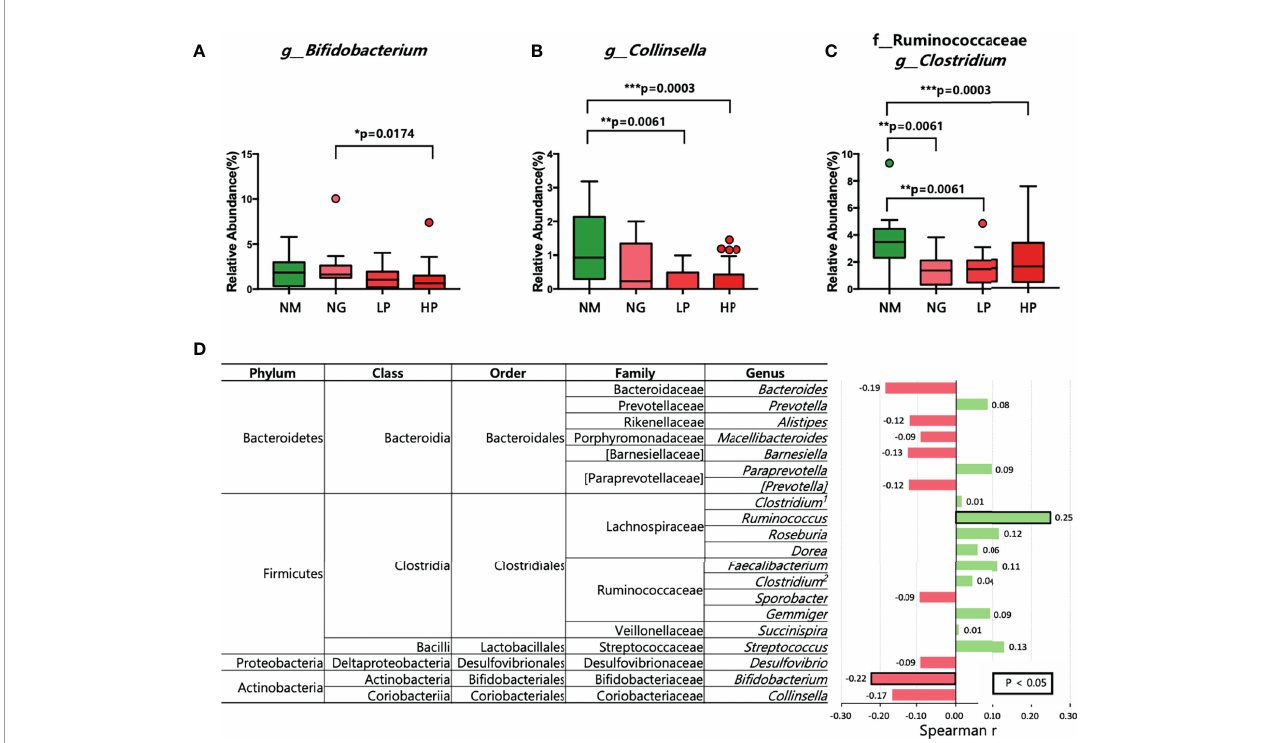
FIGURE 2 | Microbial composition at the genus level in patients with different RF levels. (A – C) Comparison of the relative abundance of (A) Bi fi dobacterium , (B) Collinsella , and (C) Clostridium using the Kruskal – Wallis test. (D) Correlations between the relative abundance of each of the 20 most abundant genera and RF levels. Positive correlations are shown in green, and negative correlations are shown in pink. The numbers in bold indicate statistically signi fi cant correlations ( p < 0.05). * p < 0.05; ** p < 0.01; *** p < 0.001. NM, normal control; NG, RA patients showing 20 or less of RF level; LP, RA patients showing over 20 and not exceeding 60 of RF level; HP, RA patients showing over 60 of RF level.